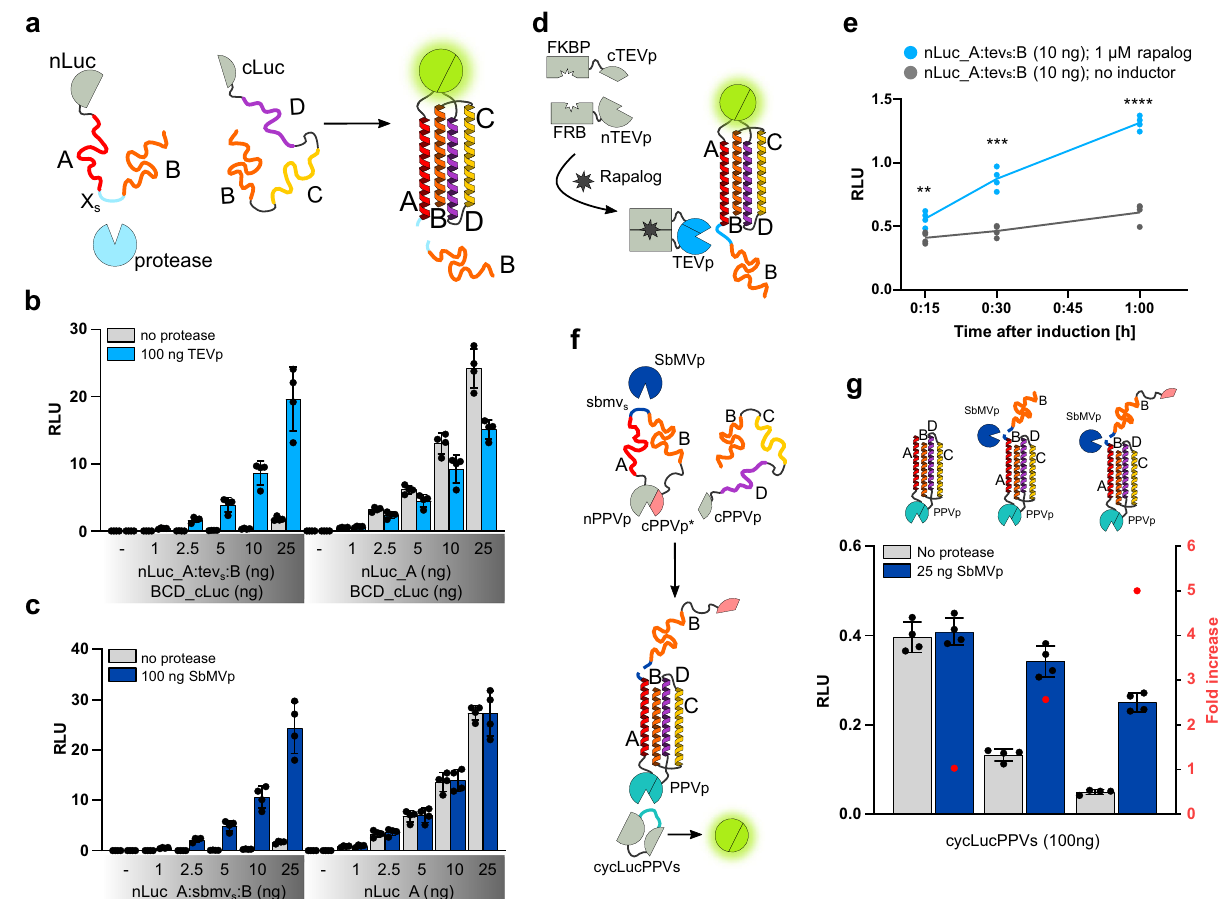
Fig.4|Dimerizationofsplit4HBdomainscanberegulatedbyproteolysisanda chemical signal. a Schematic of inducible dimerization triggered by proteolytic cleavage.TheintroductionofaproteasecleavablelinkerbetweenpeptidesAandB creates an inducible dimerization construct nLuc_A ’ B. Inhibitory peptide B is cleaved off in the presence of an appropriate protease, resulting in hetero- dimerization of nLuc_A and BCD_cLuc and reconstitution of fi re fl y luciferase. b – c TitrationofTEVp-inducible( b )orSbMVp-inducible( c )4HBdimerizationinthe absence (gray columns) or presence of TEVp ( b , light blue columns) or SbMVp ( c , dark blue columns) compared to non-inducible 4HB dimerization. d Schematic